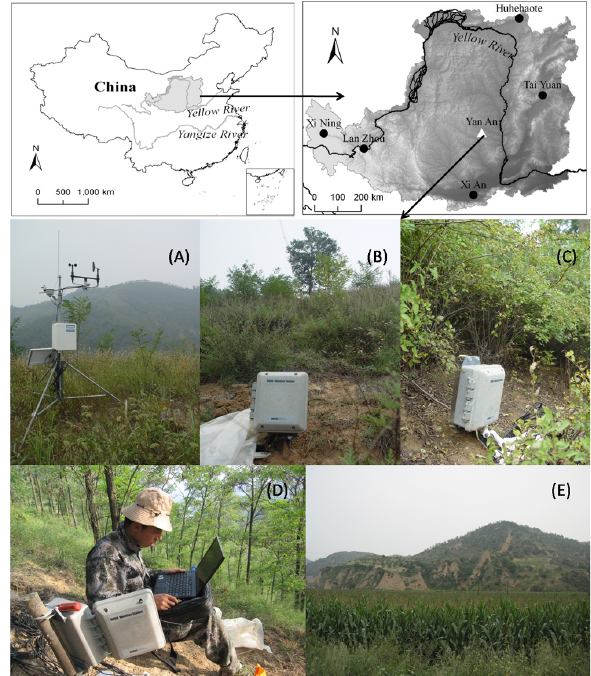
Fig. 1. Location of the study area and the typical land cover types: grass (A) , subshrub (B) , shrub (C) , plantation forest (D) and crop (E)